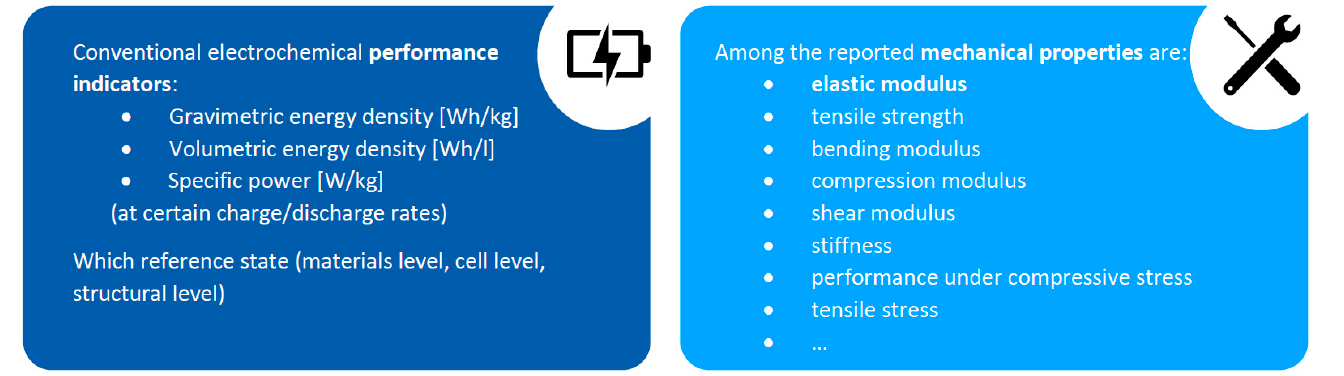
Figure 2. Common parameters for evaluation of structural batteries.